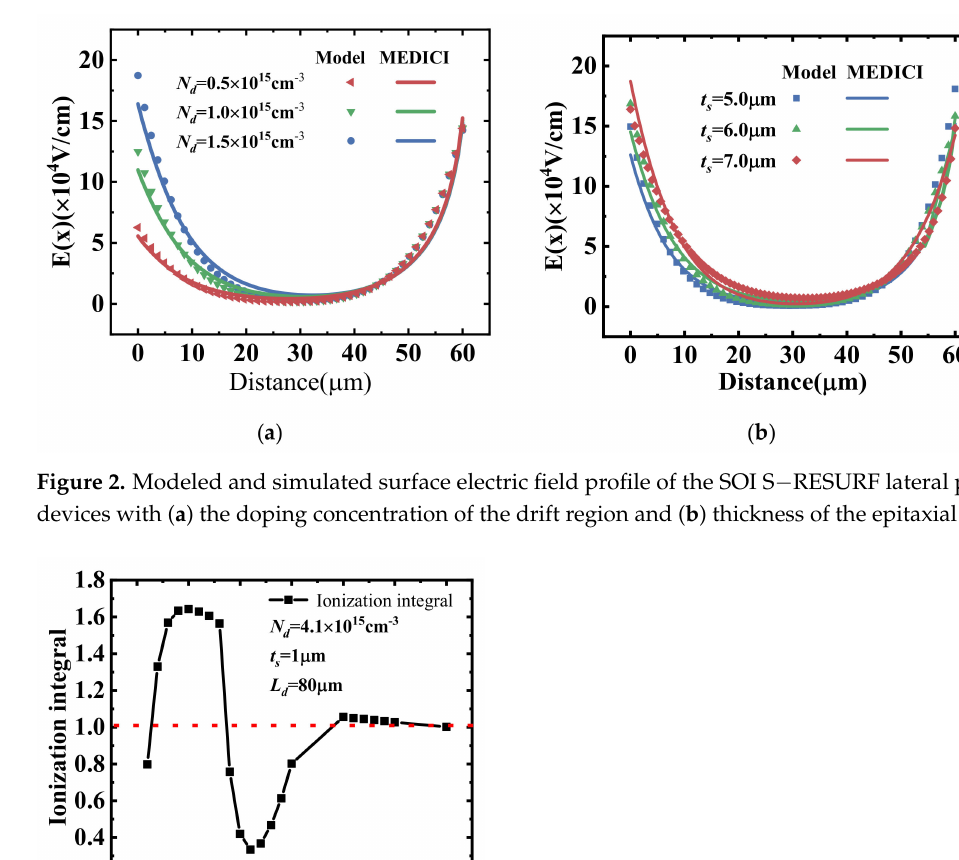
Figure 1. Schematic diagram of a typical SOI lateral power device structure.